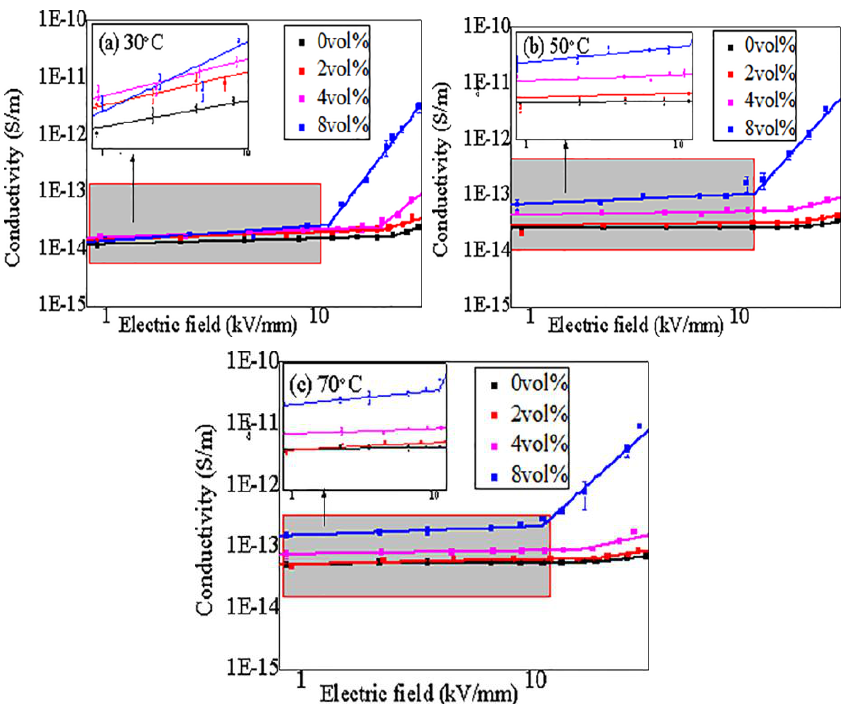
Figure 4. Conductive characteristics of composites filled with CCTO at different temperatures.